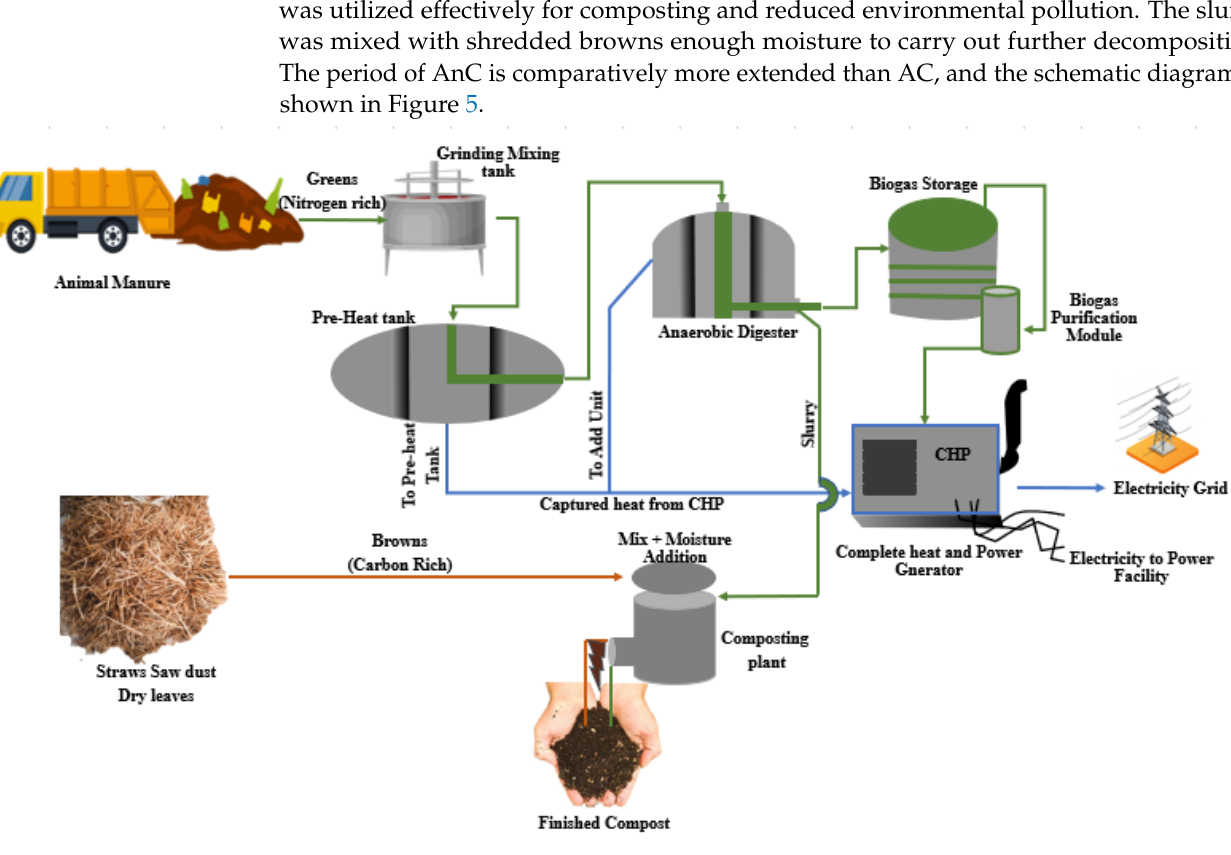
Figure 5. Schematic diagram of